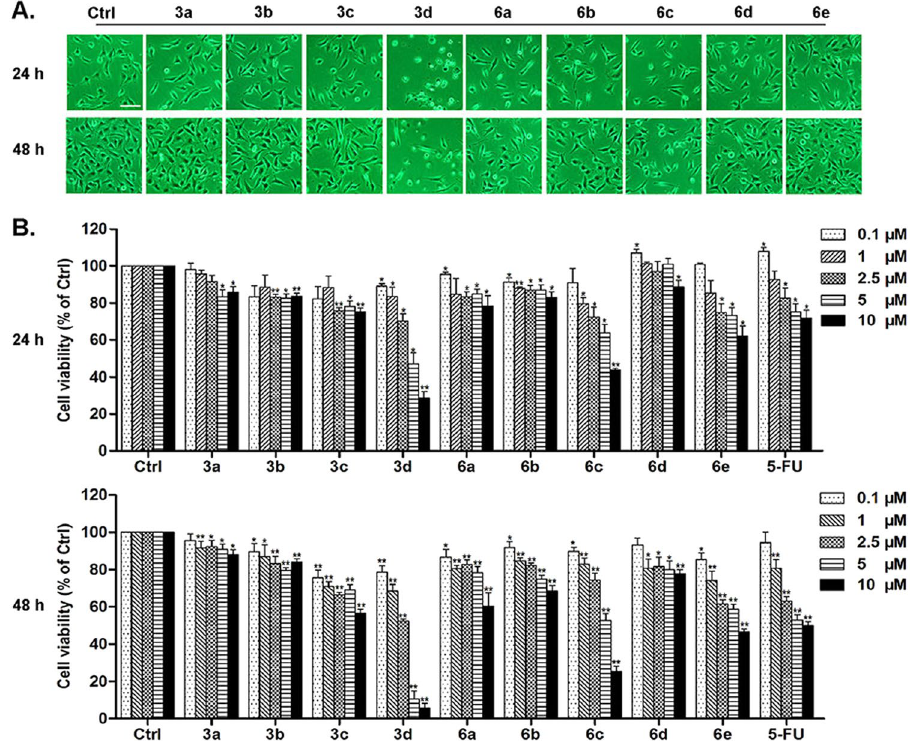
Figure 2. Effects of compounds 3a-3d, 6a-6e on morphology and viability of A549 lung cancer cells. A549 lung cancer cells were treated with compounds 3a- 3d , 6a-6e (2.5 μ M) or 0.1% DMSO (control) for 24 h or 48 h ( A ). Microscopic photographs (200 × ) were taken by using the inverted phase contrast microscope (Nikon). Scale bar: 20 μ m. A549 cells were treated with compounds 3a- 3d , 6a-6e at 0.1, 1, 2.5, 5, 10 ( μ M) for 24 h or 48 h ( B ). The control group (Ctrl) was treated with 0.1% DMSO (V/V). Cell viability was analyzed by SRB assay. 5-FU was utilized as a positive drug control. Results are mean ± SEM ( * p < 0.05, ** p < 0.01 vs control. N = 3).